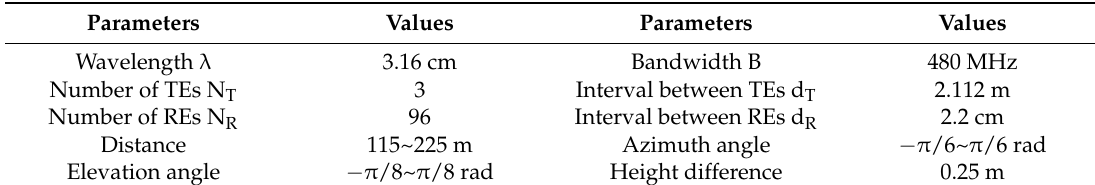
Figure 17. MIMO radar system for the experiment.